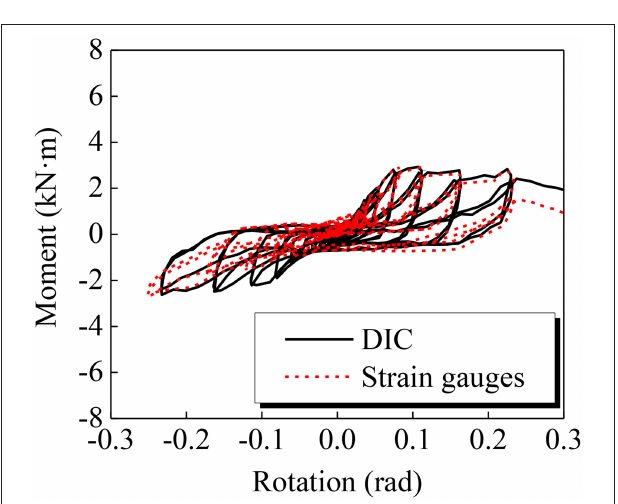
FIGURE 12 | Comparison of results measured from DIC and strain